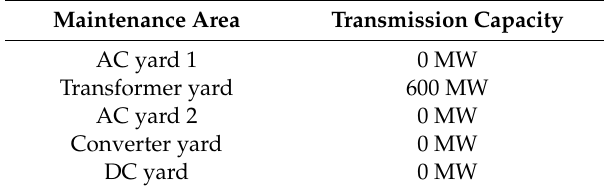
Table 3. Transmission capacity during maintenance for di ff erent maintenance areas.